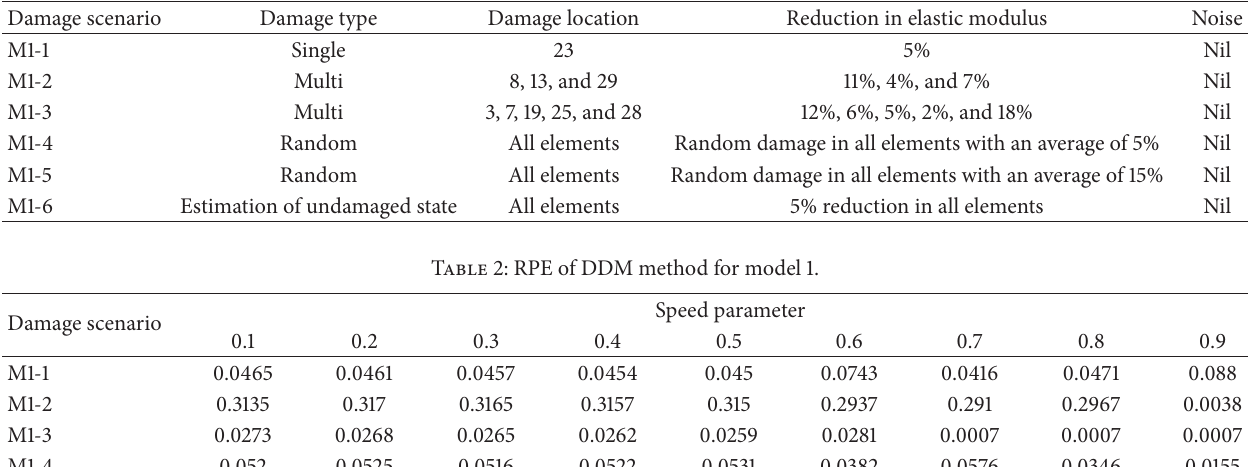
Table 1: Damage scenarios for multispan bridge.